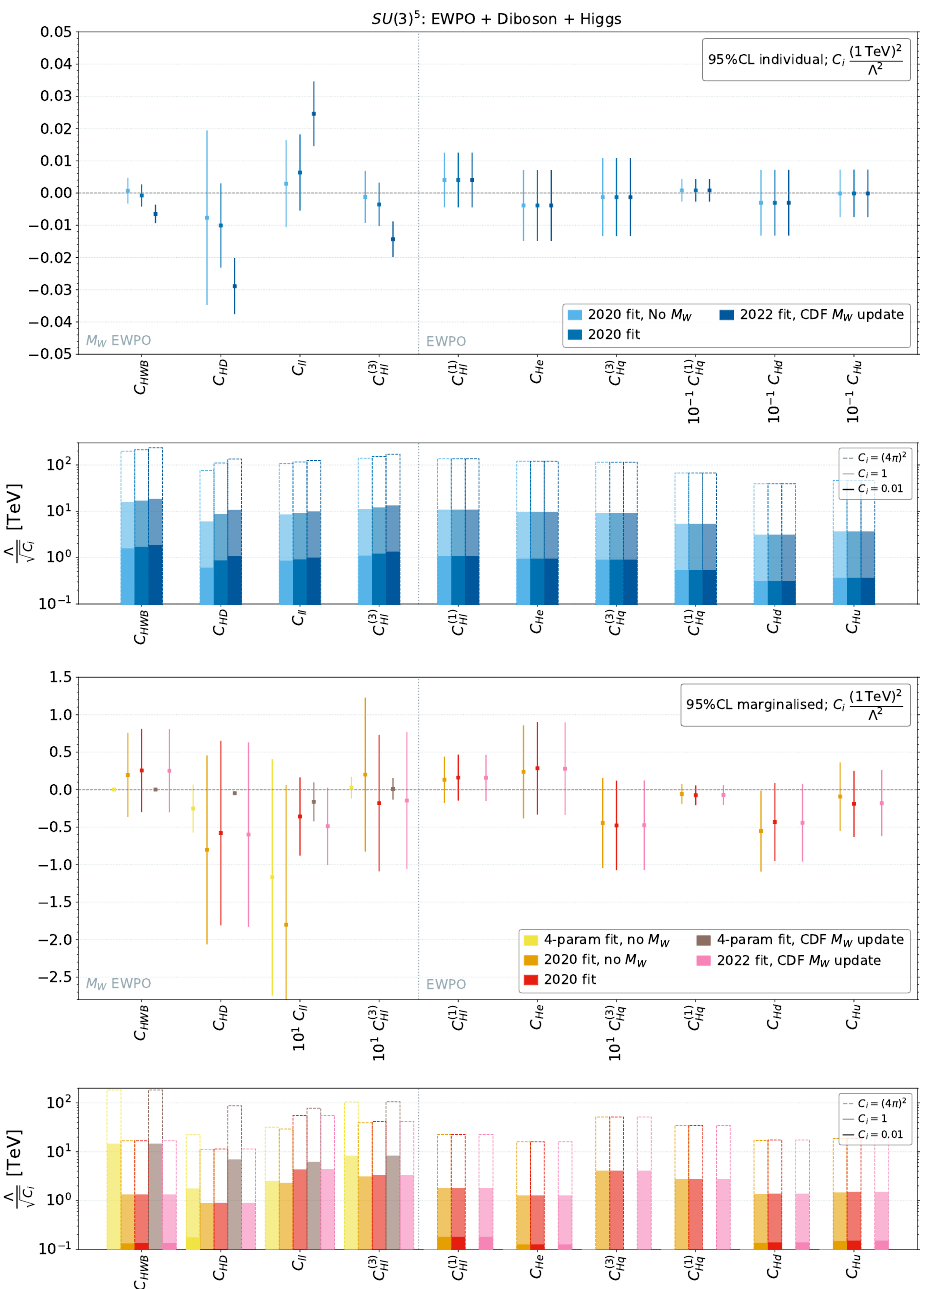
Figure 3 . Constraints from global linear fits to measurements of m W combined with Higgs, diboson and electroweak precision observables made using Fitmaker [3] on the individual and marginalised operator coefficients C i (1 TeV) 2 / Λ 2 (top and third panels, respectively) and the corresponding scales Λ for the indicated values of the dimensionless coupling C i at the 95% confidence level (second and bottom panels). In the upper panels we compare results for the individual operators dropping the m W constraint, using the m W constraint applied in [3], and using the new CDF measurement of m W . In the lower panels, we compare the constraints obtained marginalising either over the full set of 20 operators, or over the four operators that can modify m W